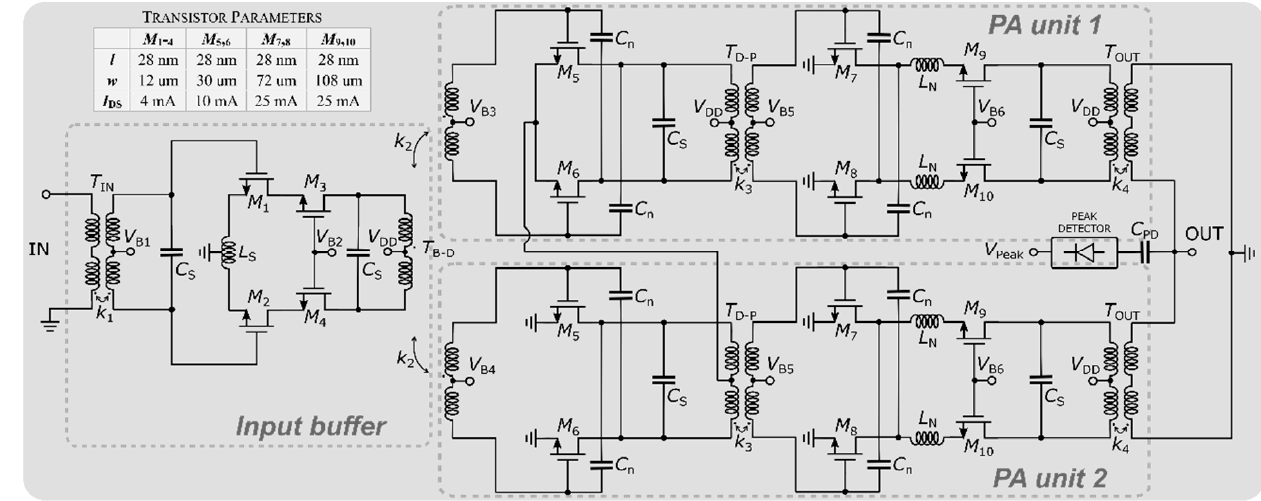
Figure 2. Schematic of the proposed two path PA.